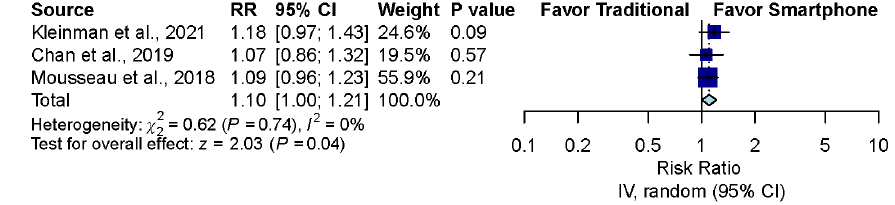
Figure 4. Sensitivity analysis after excluding the simulation study.